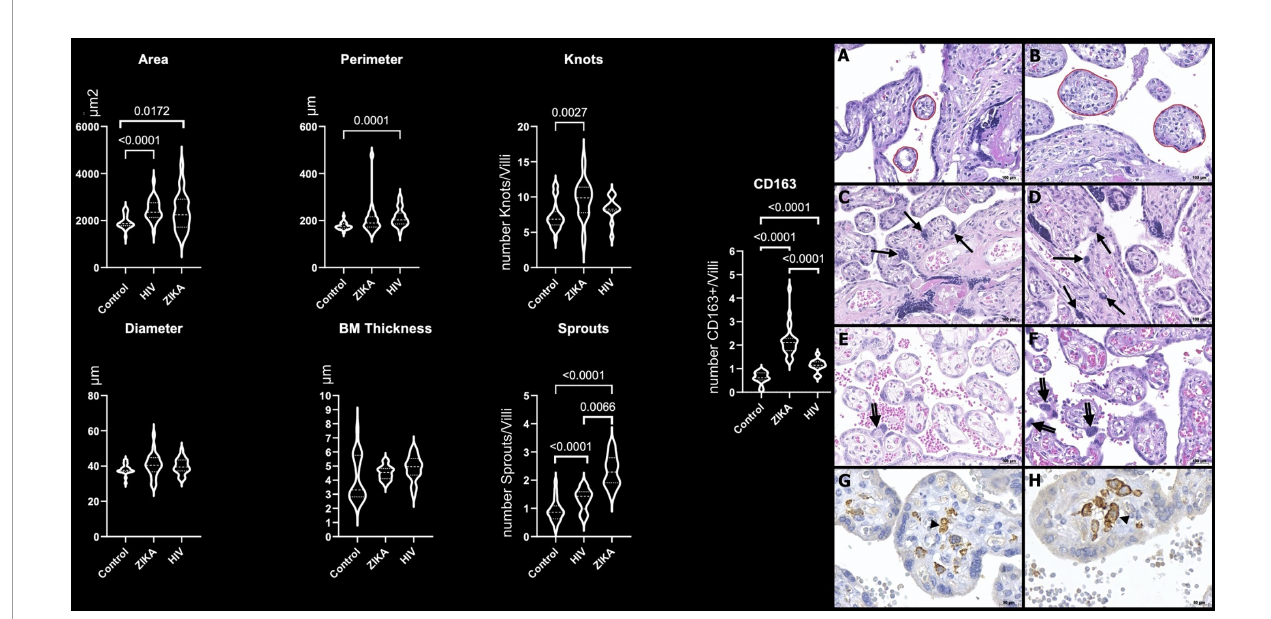
FIGURE 1 | Morphometric analysis of placental specimens from women infected with ZIKV during the pregnancy compared to the HIV and N-control groups. Perimeter, diameter, and basal membrane (BM) thickness in µm; area in µm 2 ; number of knots, sprouts, and CD163+ HCs per villi (CD163/villi). Photomicrography of a placental sample stained with H&E showing the perimeter of villi (red freehand drawing) in N-control group (A) and ZIKV group (B) ; the number of syncytial knots/ villi (arrows) in N-control group (C) and ZIKV-group (D) ; the number of sprouts/villi (double arrows) in N-control group (E) and ZIKV group (F) . Original magni fi cation: 200×. Scale bars: 100 m m. Photomicrography of immunostaining with CD163 highlighting Hofbauer cell (arrowhead) in the N-control group (G) and ZIKV group (H) . Original magni fi cation: 400×. Scale bars: 50 m